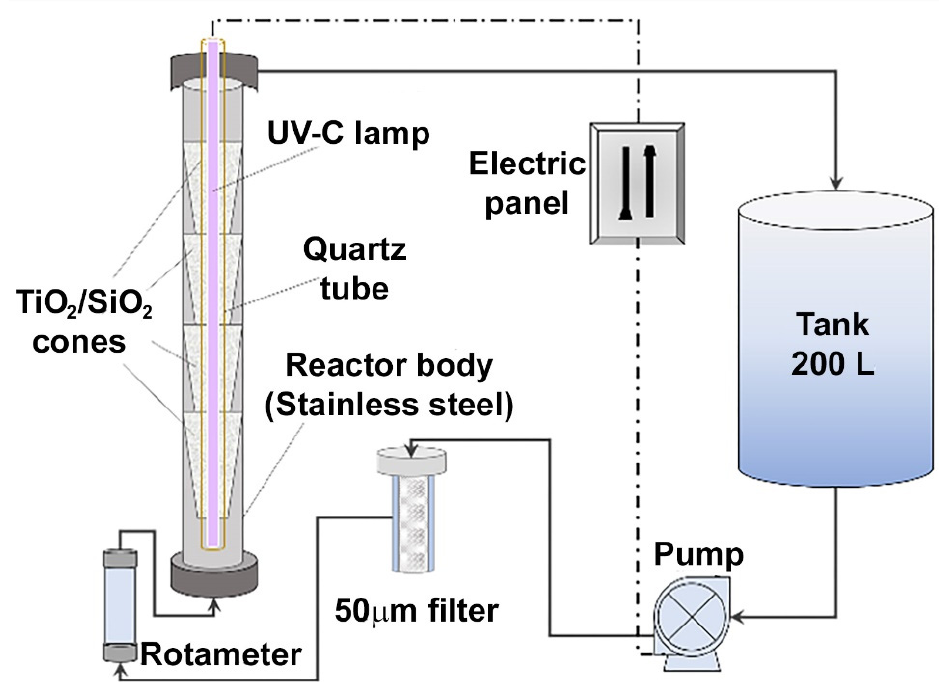
Figure 15. Photoreactor system used for photolysis and photocatalytic organic compounds degradation